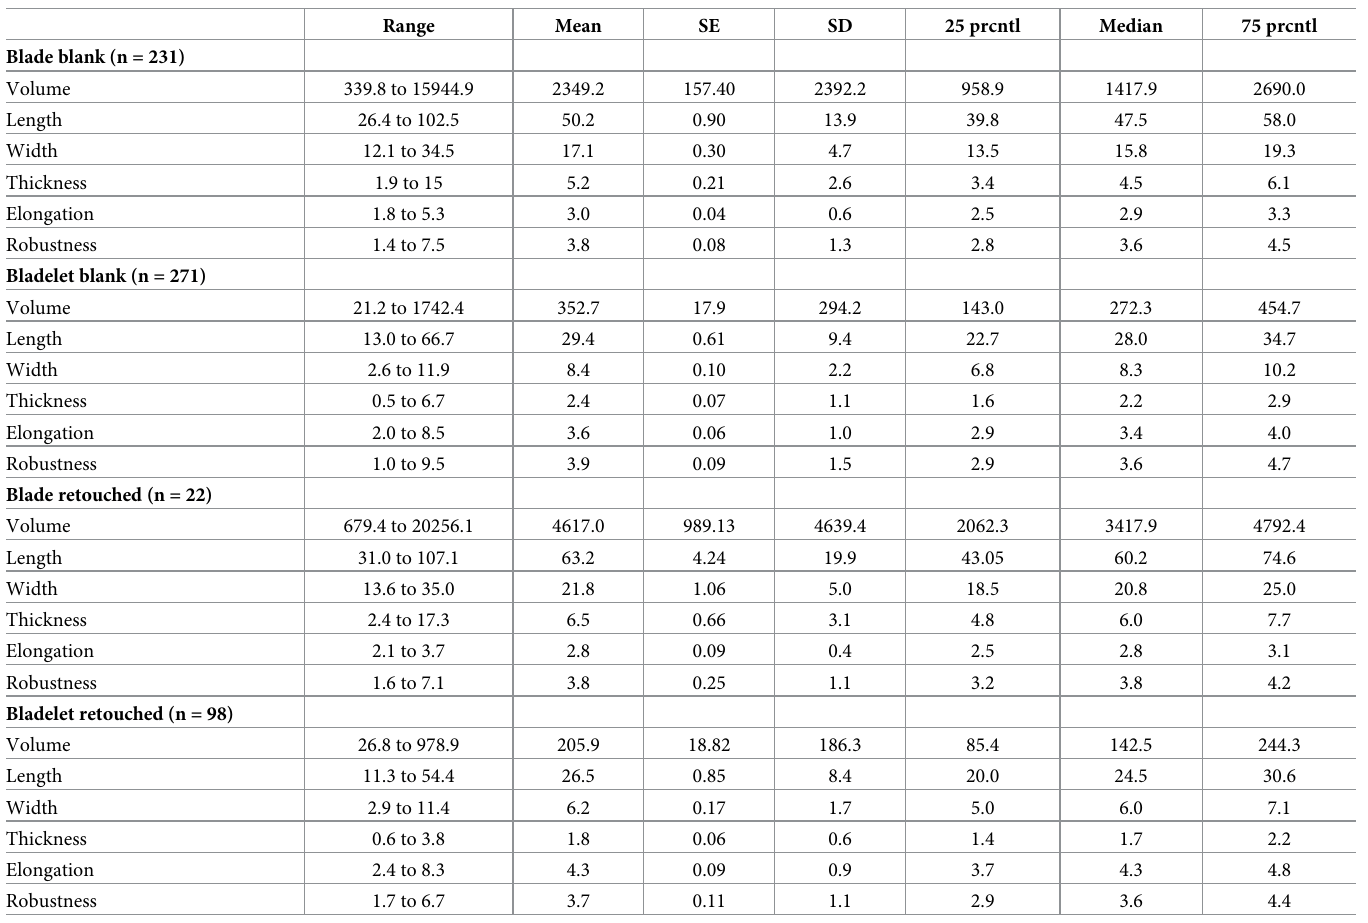
Table 2. Descriptive statistics of the metric attributes of all classes of artifacts analyzed in this study. Linear measurements are in millimeters while volume is in cubic millimeters. Elongation refers to the length to width ratio, while robustness refers to width to thickness ratio. Abbreviations: SE, standard error; SD, standard deviation; prcntl,